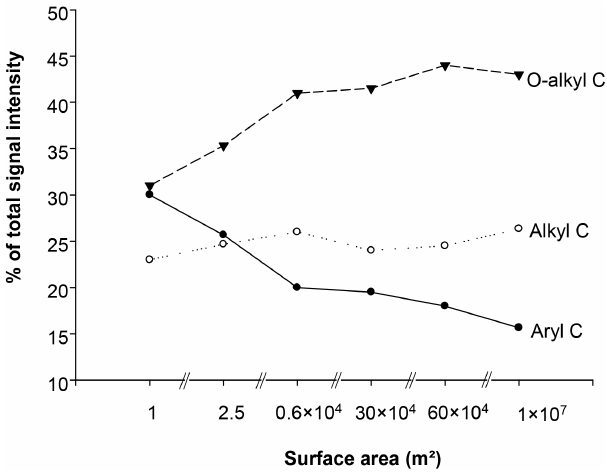
Figure 5. Proportion of signal intensity of 13 C CPMAS NMR spec- tra recorded for EOM collected at different spatial scales assigned to aryl C, alkyl C and O-alkyl